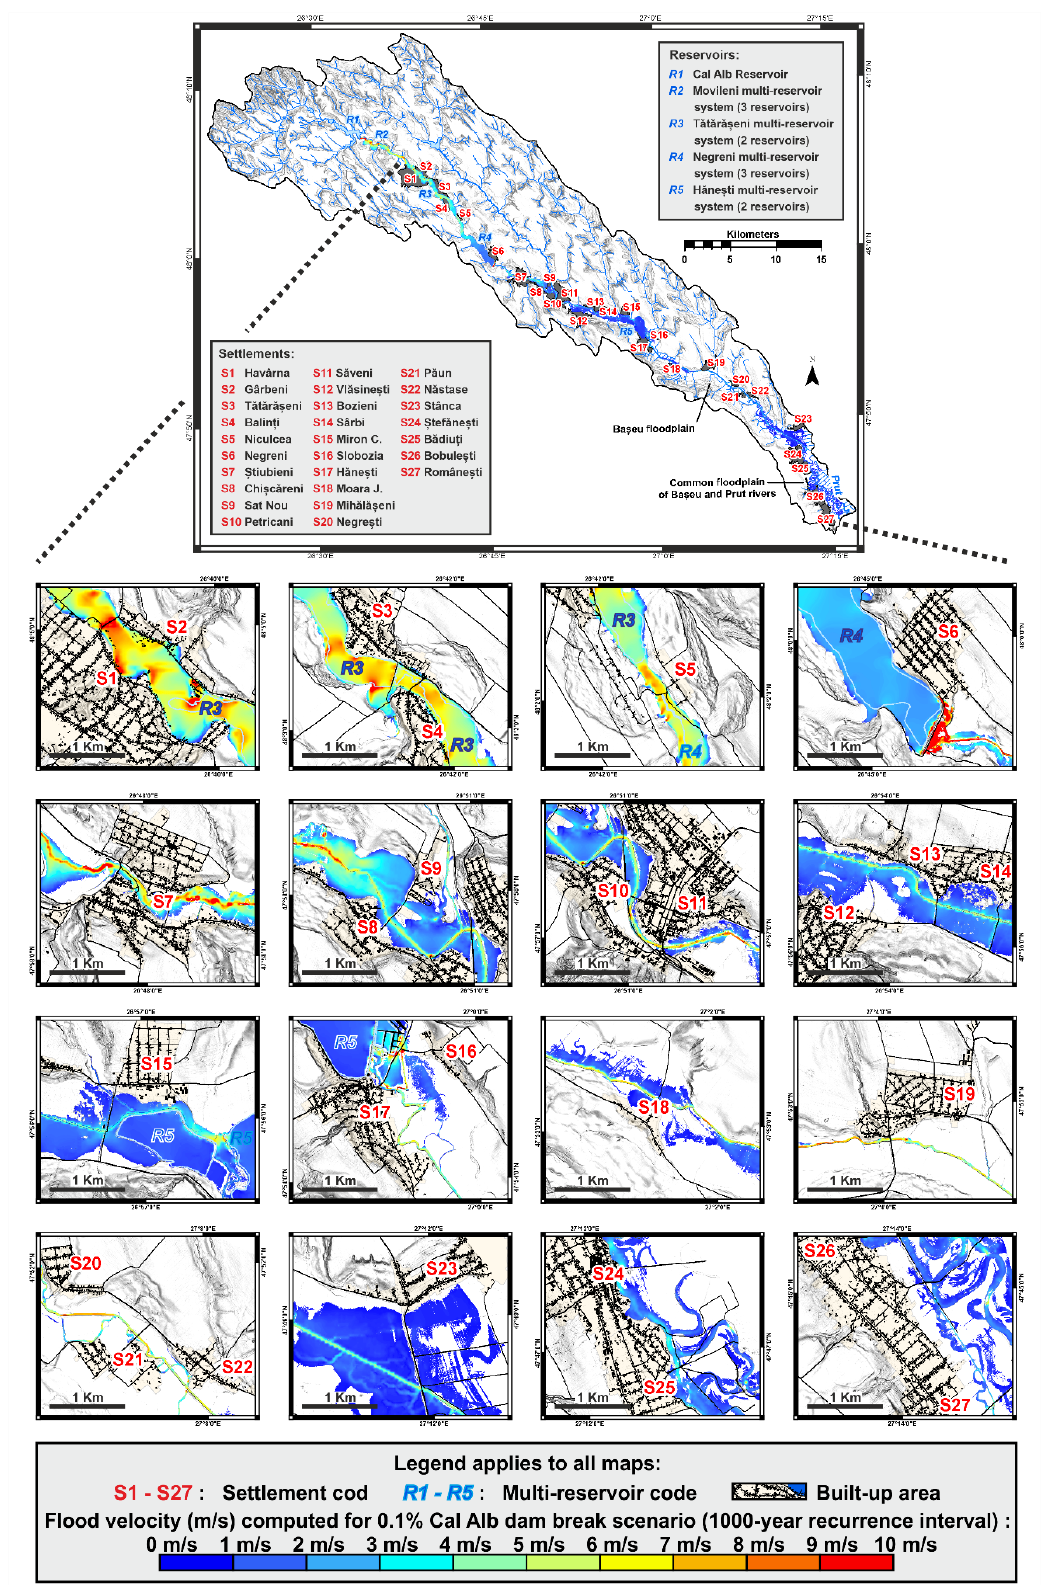
Figure 6. Flood velocity (m/s) within built-up area of 27 settlements located downstream of the Cal Alb reservoir computed for the worst dam break scenarios with 0.1% (1000-year) recurrence intervals.